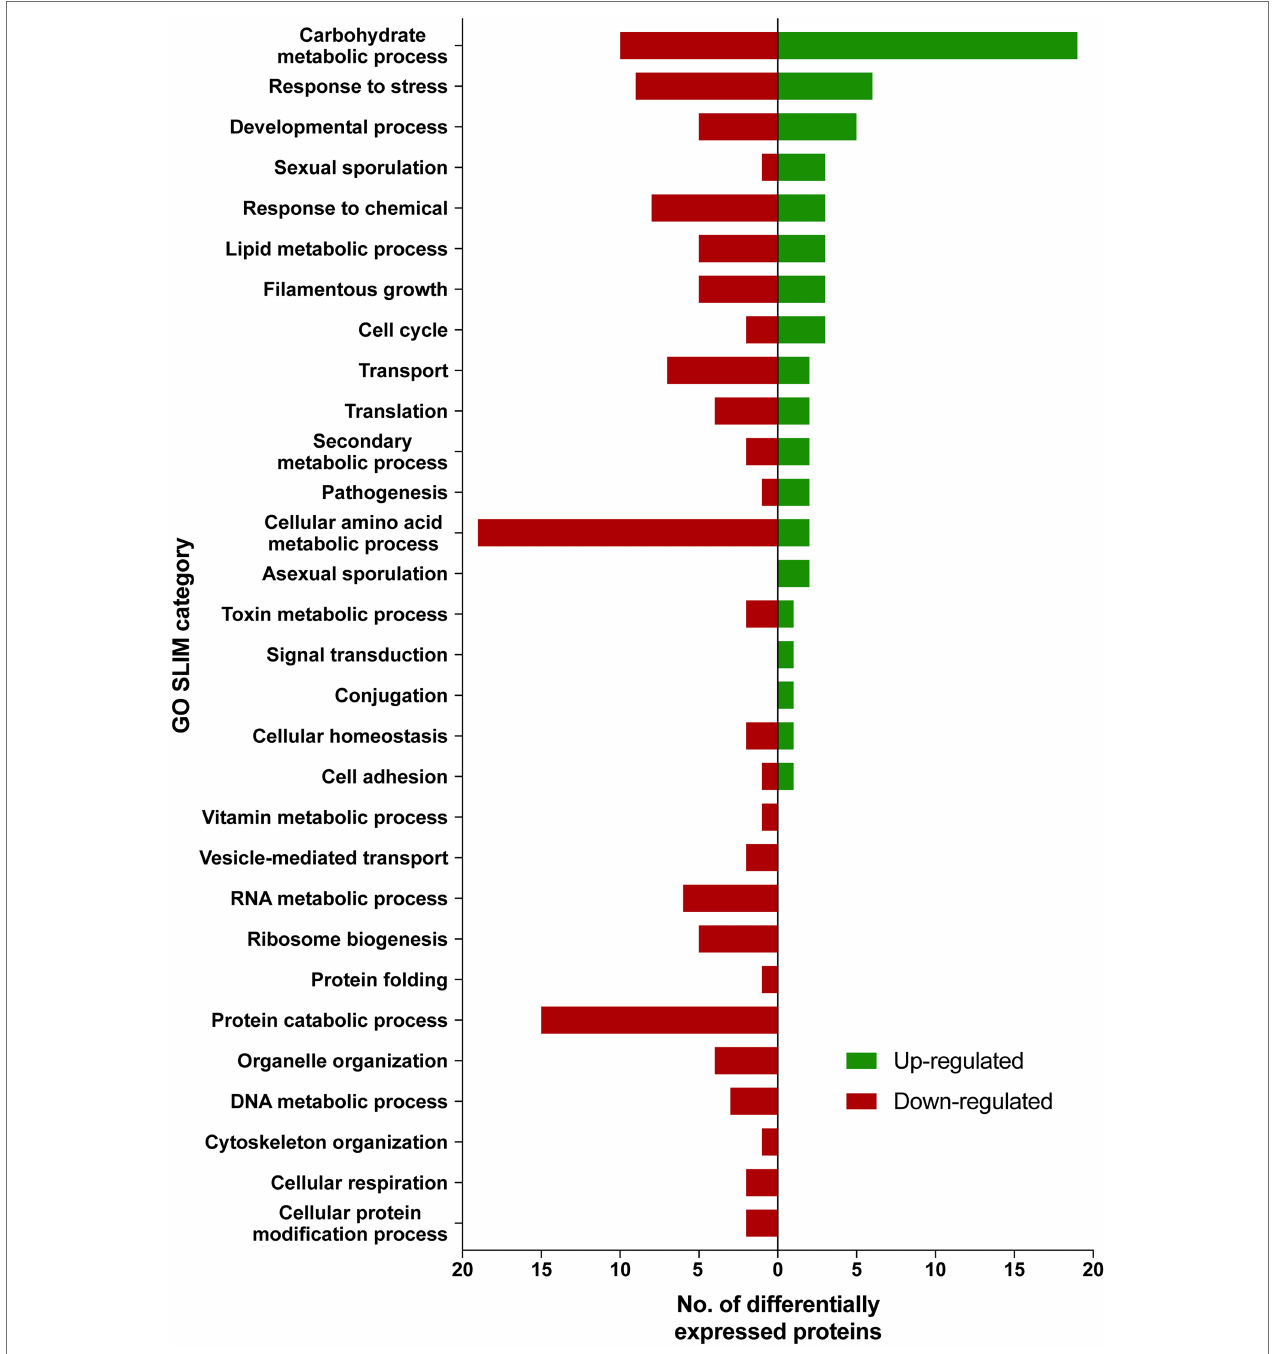
FIGURE 1 | AspGD GO Slim terms of differentially expressed proteins in ISS-grown JSC-093350089. Differentially expressed proteins in FC > |2|, p < 0.05 were mapped to terms representing various biological processes using AspGD Gene Ontology (GO) Slim